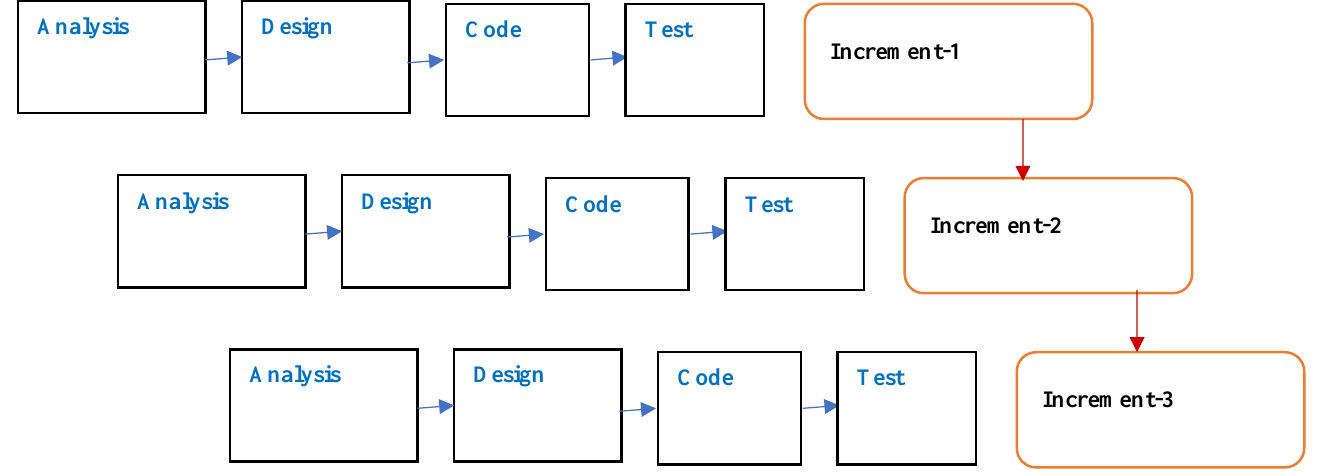
Fig. 4. Incremental build model [27]